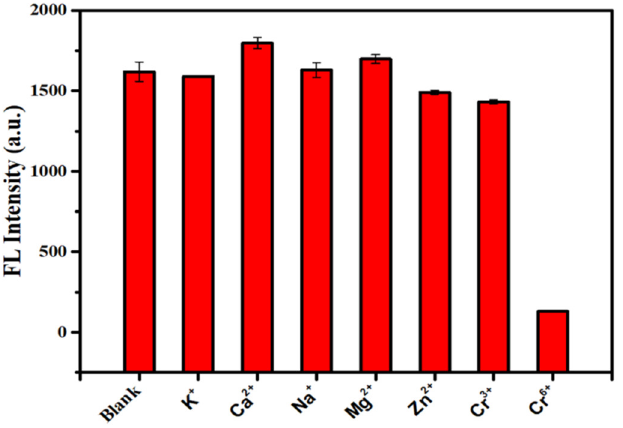
Figure 5. Response of SQDs to different ions.